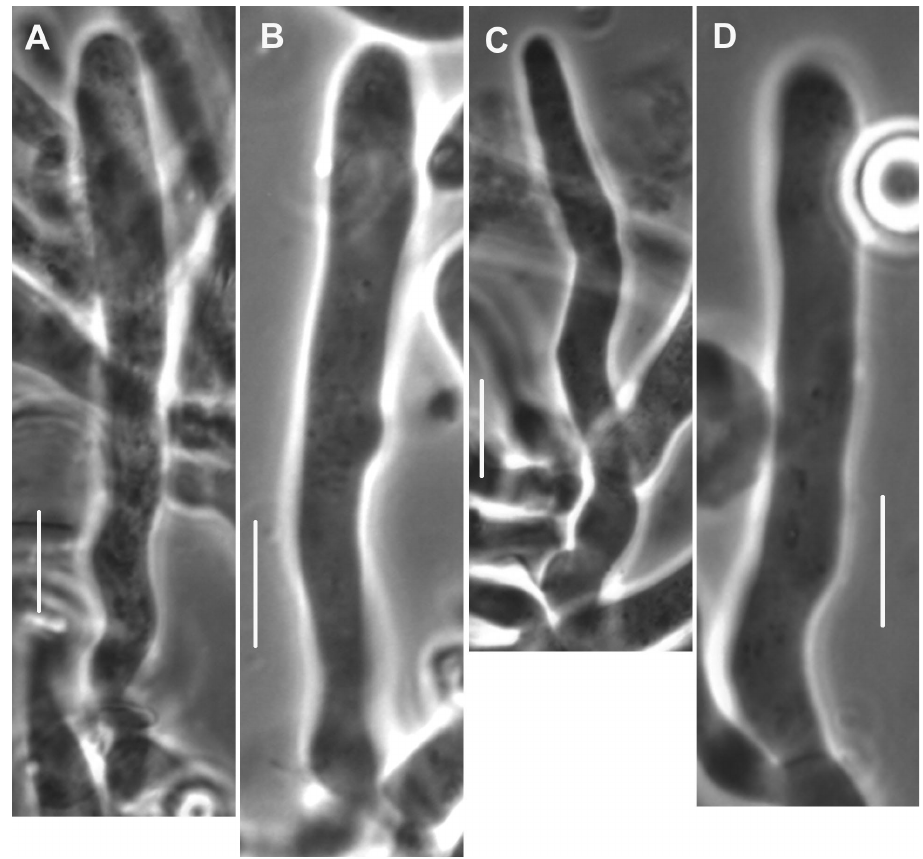
Figure 36. Mycetinis kallioneus . Pleurocystidia. Standard bars = 10 µm. TB 85-209